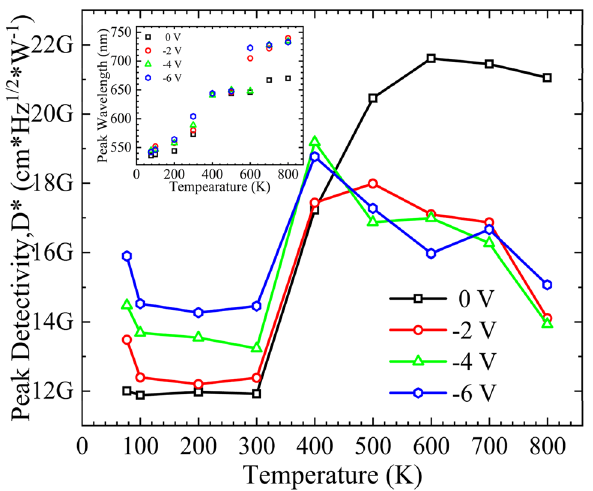
Figure 8. The peak specific detectivity at different biased conditions. Inset shows the redshift corresponding to the peak specific detectivity.